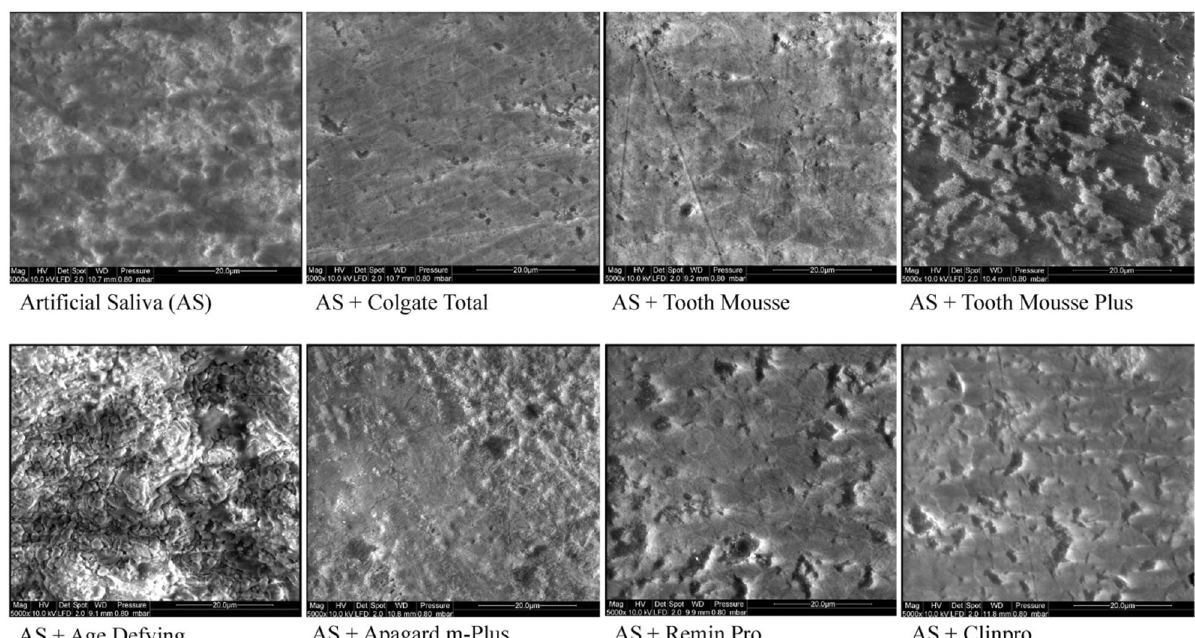
Figure 1. Representative enamel surface SEM images of treated subsurface lesions (× 5000